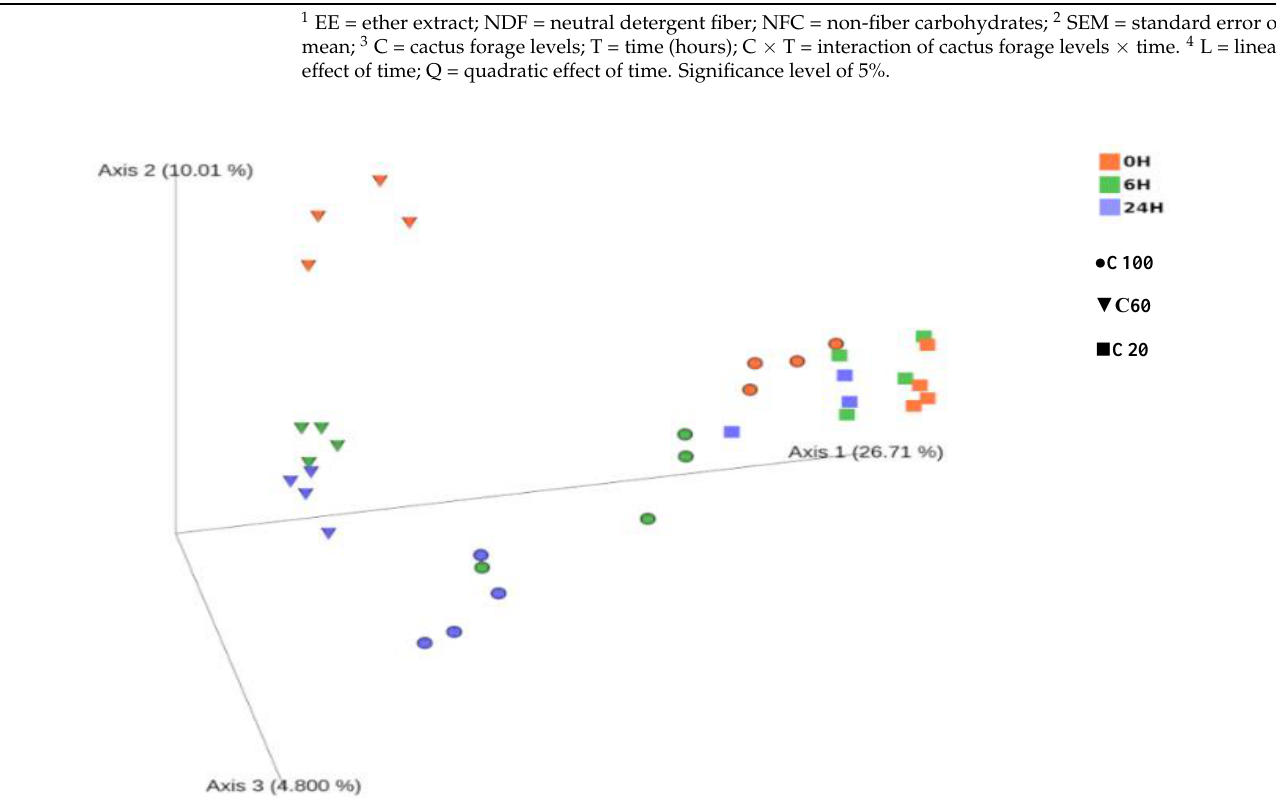
Figure 4. Beta diversity represented by a 3D PCoA graph showing the degree of dissimilarity based on the unweighted UniFrac distance matrix. C100 = 100% cactus forage; C60 = 60% cactus forage and 40% buffel grass hay; C20 = 20% cactus forage and 80% buffel grass hay; 0H = 0 h; 6H = 6 h and 24H = 24 h of exposure to air.